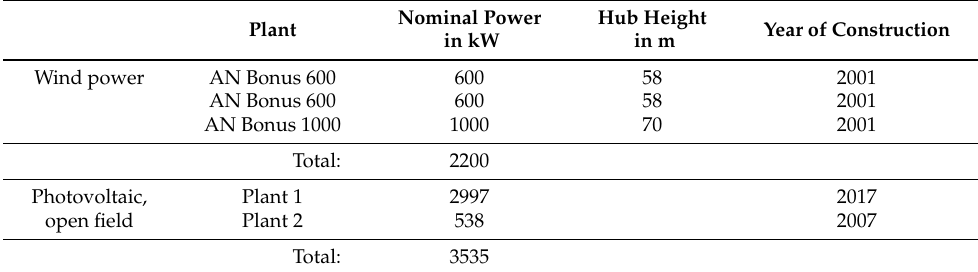
Table 3. Renewable energy sources at the selected location (i.e., Steinberg am Wald, latitude: 50.404387°, longitude: 11.332333°) [48].